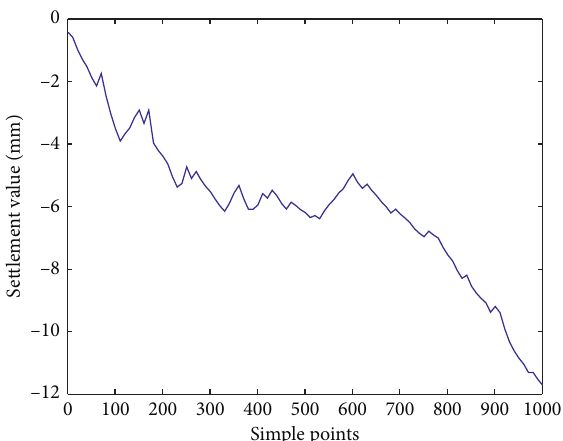
Figure 4: Amplitude-frequency characteristic analysis.